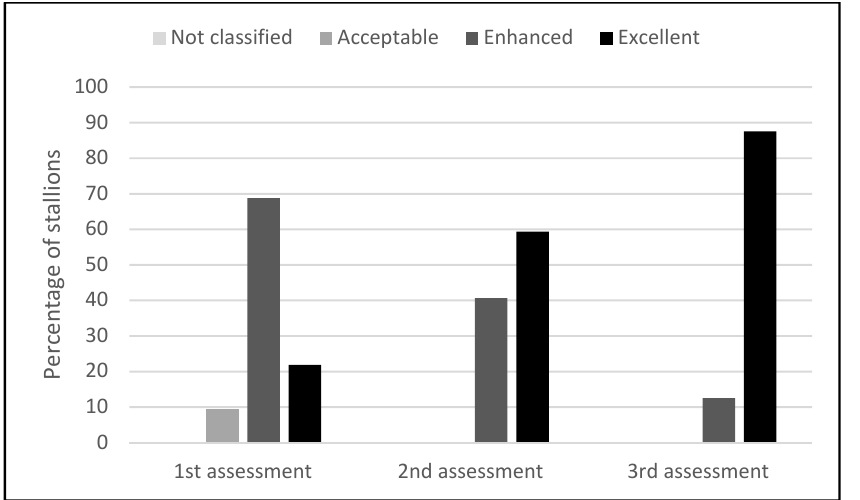
Figure 2. Percentages of stallions in the established qualitative welfare classes (acceptable, enhanced, and excellent) in the three welfare assessments performed.